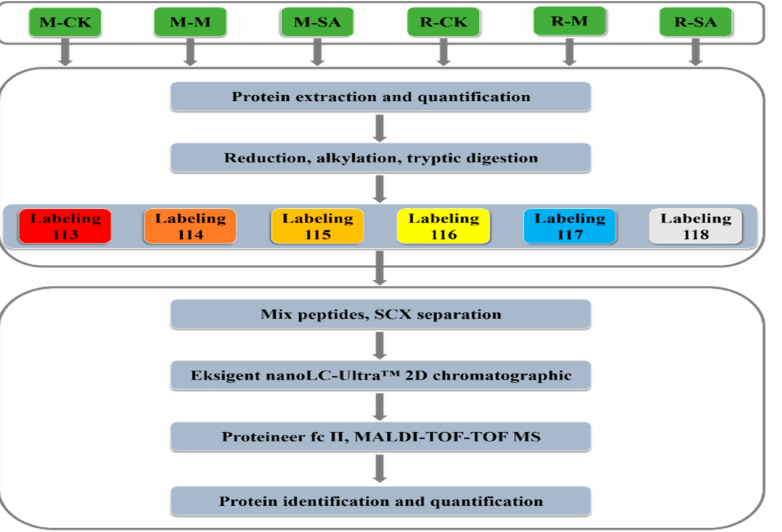
Figure 1. The flowchart depicts the main steps of protein expression analysis in the rice blast-resistant Minghui and the blast susceptible Nipponbare cultivars by conducting six-plex isobaric tagging and the nano Liquid Chromatography-Matrix-assisted laser desorption/ionization time-of-flight mass spectrometer (nanoLC-MALDI-TOF-TOF MS). The treatment groups in the flow chart were abbreviated as M-CK, M-M, and M-SA for the Minghui cultivar sub-groups set as a control, infected with Magnaporthe grisea , and sprayed with salicylic acid, respectively. Treatment samples of the susceptible Nipponbare cultivar were also abbreviated as R-CK, R-M, R-SA for samples set as control, infected with Magnaporthe grisea , and sprayed with salicylic acid,